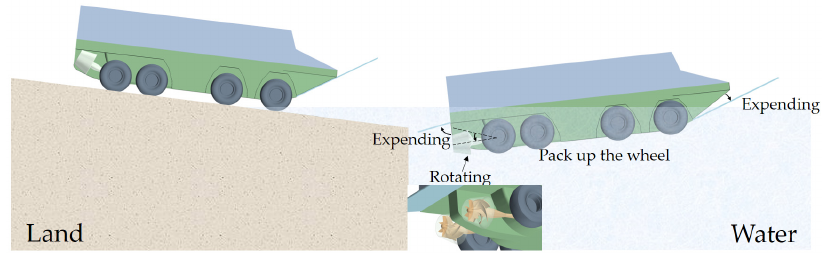
Figure 1. The geometry of the PJPWAV.